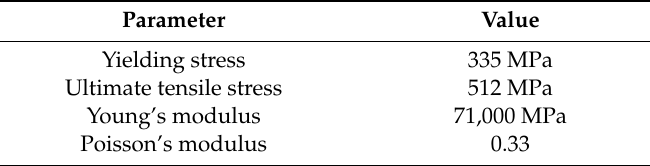
Figure 10. Mil Mi-8 helicopter FE model cutaway view. Table 5. Fuselage material properties.